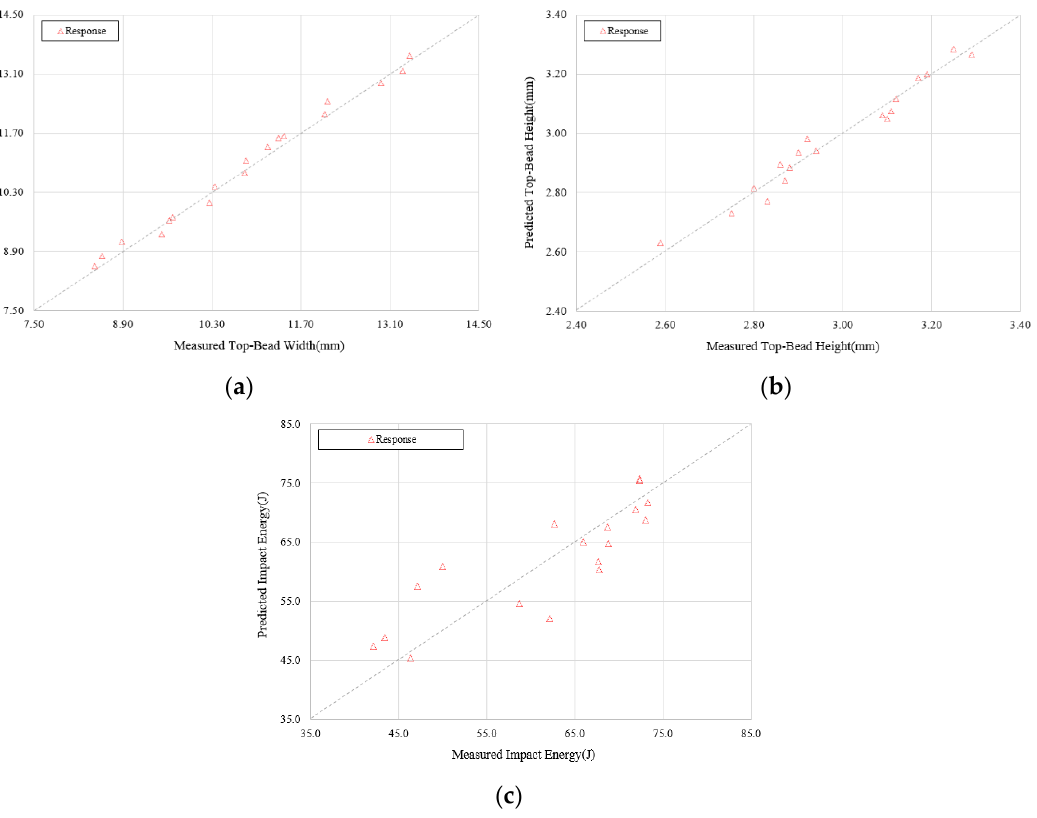
Table 12. Analysis of variance tests for predicted model for welding factors.